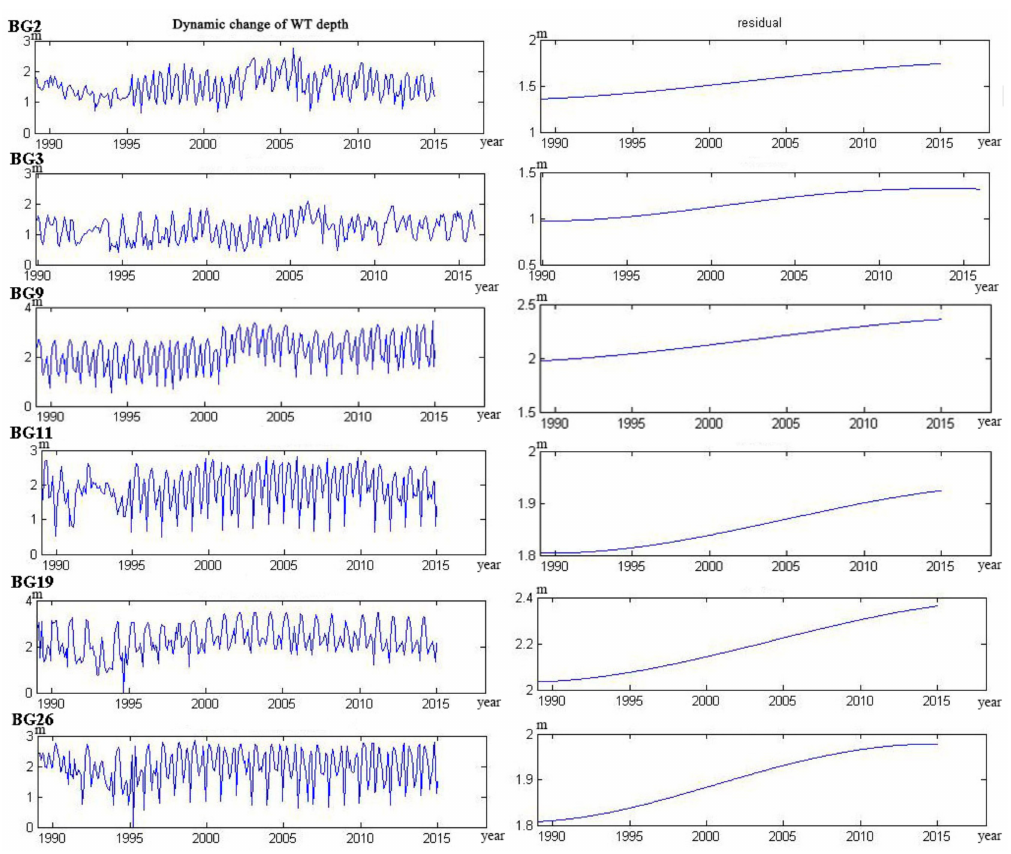
Figure 8. Empirical Modal Decomposition of the second type of